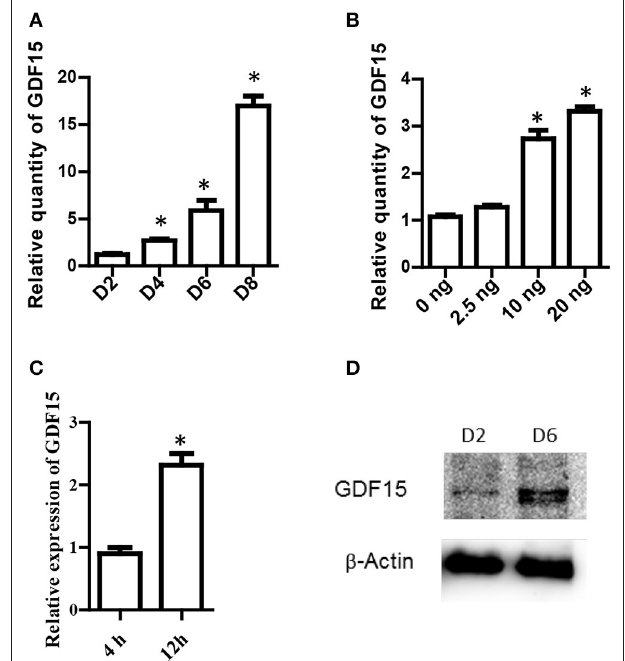
FIGURE 1 | GDF15 expression in DCs. (A) A time course of GDF15 expression in DCs. DCs (10 6 cell/well) were cultured from bone marrow progenitors in the presence of IL-4 and granulocyte/macrophage colony stimulating factor (GM-CSF). Cultured DCs were collected on day 2, 4, 6, and 8 for RNA extraction. The level of GDF15 mRNA was detected by qRT-PCR and GAPDH was used as loading control. Relative quantity of GDF15 mRNA was the expression of GDF15 in Day 2 DCs. n = 4, One way ANOVA was conducted for statistical analysis. (B) rhGDF15 increased GDF15 expression in DCs. BM-derived DCs were cultured and a variety of concentrations of rhGDF15 were added on day 4. Twenty-four hours after treatment, GDF15 expression in DCs was detected using qRT-PCR. GDF15 expression was normalized with control DCs without rhGDF15 treatment. n = 4, One way ANOVA was conducted for statistical analysis. (C) The up-regulation of GDF15 in DCs by rhGDF15 was time related. BM-derived DCs were treated with 2.5ng/ml rhGDF15 on day 5. n = 3, the student T -test was conducted for statistical analysis. GDF15 expression in DCs was detected 4h and 12h